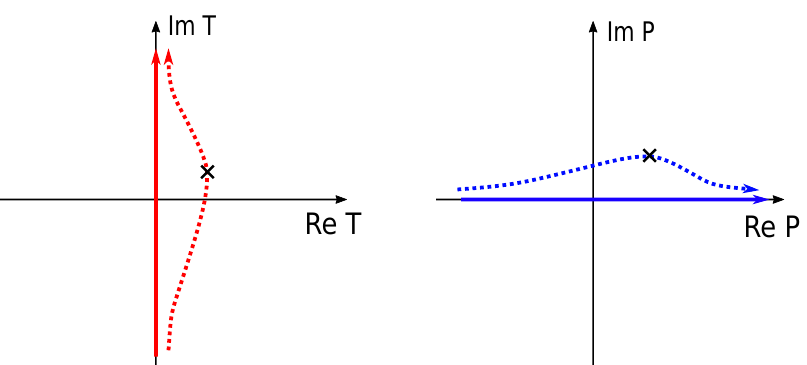
Figure 4 . The contours of the path integrations in the complex planes of T i While the original paths (solid lines) are de(cid:12)ned along the imaginary and real axes respectively, the saddle points in general lie away from the original paths. The saddle point can be reached by deforming the paths as denoted in the dashed lines. Fluctuations around the saddle point are de(cid:12)ned along the deformed